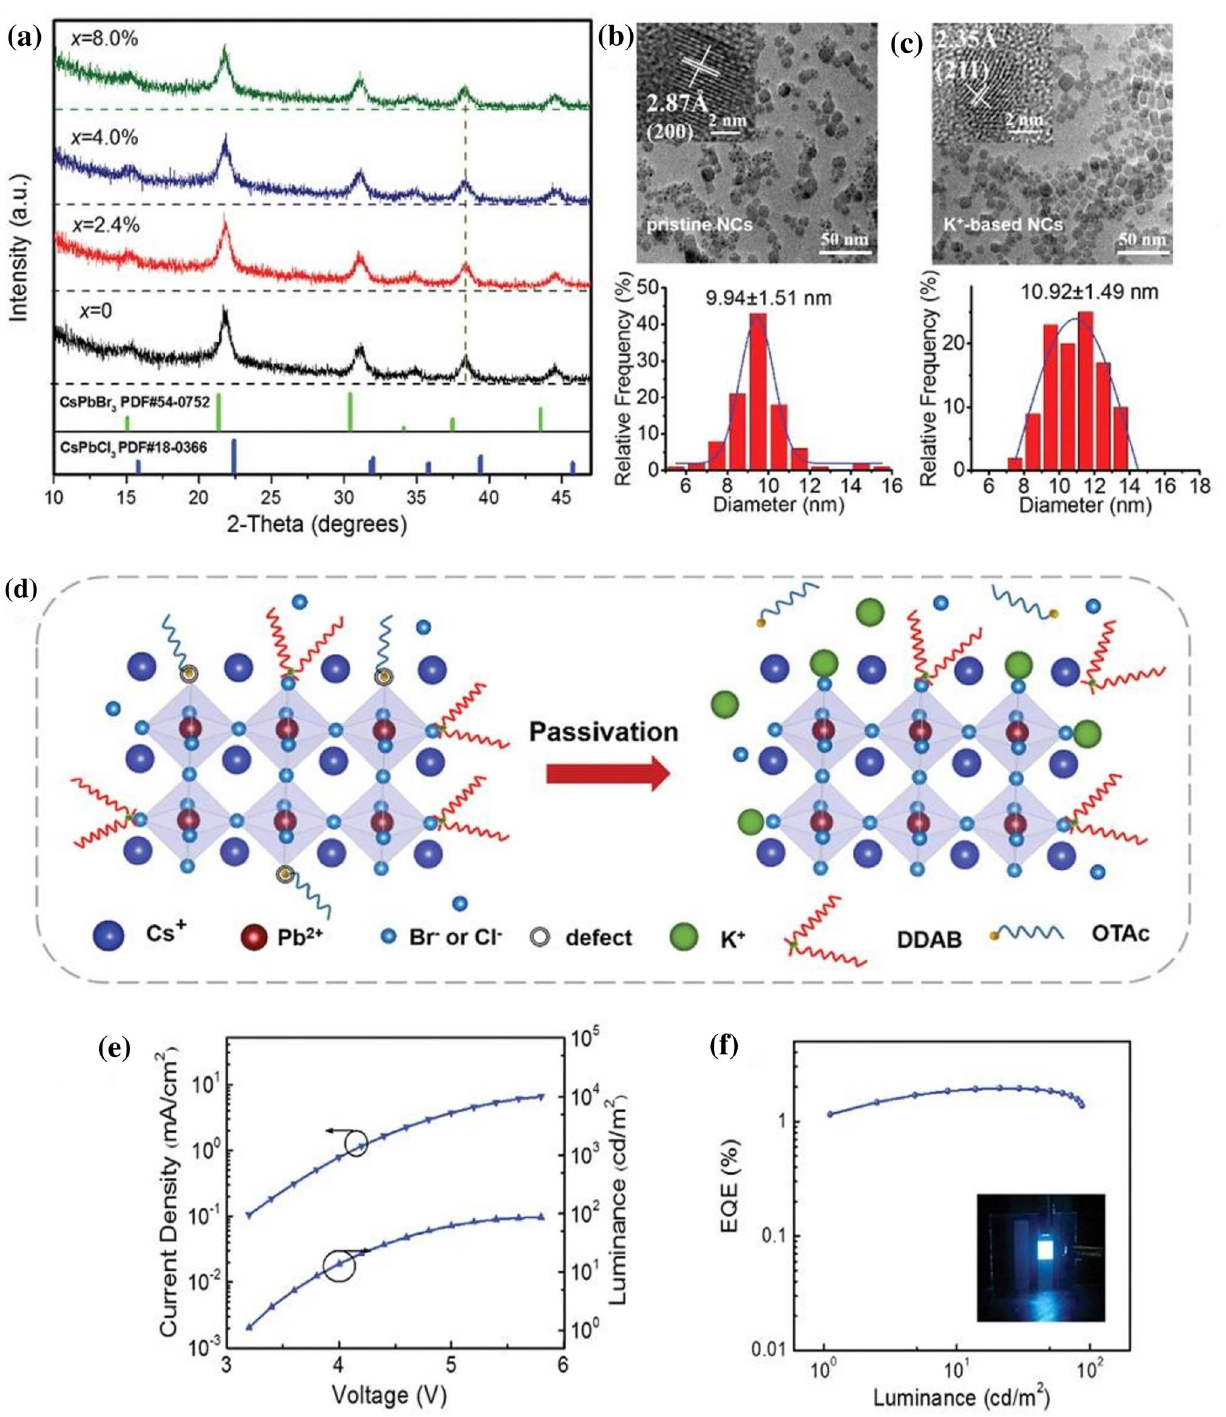
resolution TEM images. d Schematic illustration of potassium pas- Fig. 7 a XRD patterns of perovskite films with different x values and sivation. e Current density–voltage–luminance curves and f EQE- standard XRD patterns of CsPbBr and CsPbCl . b and c TEM images 3 3 luminance curve for LED device based on x = 4.0%. Adapted with of pristine and K + based (4.0% in terms of nominal K + ratio) NCs and permission from ref [87], copyright 2020, WILEY ‐ size distribution analysis; the insets show the corresponding high-